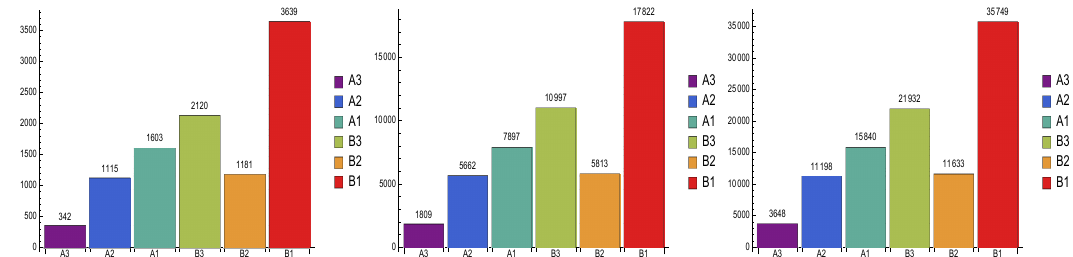
Figure 4. Classification of ( Left ): when the size is 10,000. ( Center ): when the size is 50,000. ( Right ): when the size is